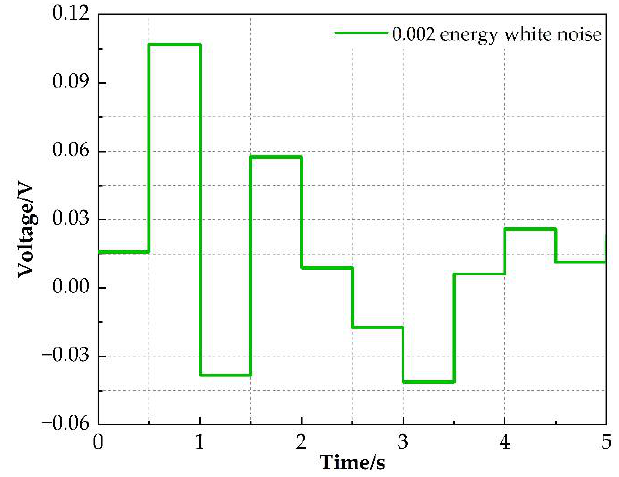
Figure 12. 0.002 energy white noise.